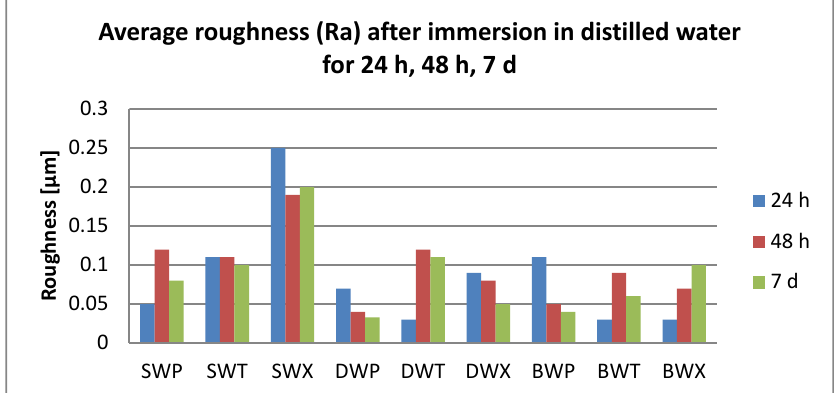
Figure 8. Mean values for average surface roughness (Ra) for the tested samples after immersion in Coca-Cola.